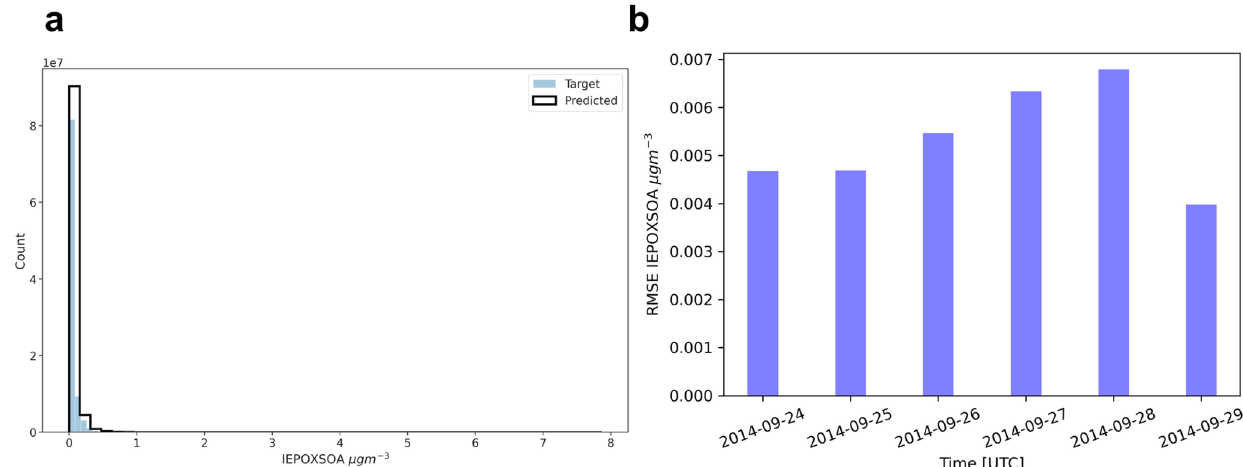
Fig. 5 Target and predicted IEPOX-SOA distributions and RMSE over time. a IEPOX-SOA distribution in the computational domain for a 6-day simulation for WRF-Chem Default (target) and the WRF-Chem DNN (predicted) run. b The RMSE between WRF-Chem Default and WRF- Chem DNN computation of IEPOX-SOA at 00:00 UTC of every day for the 6-day